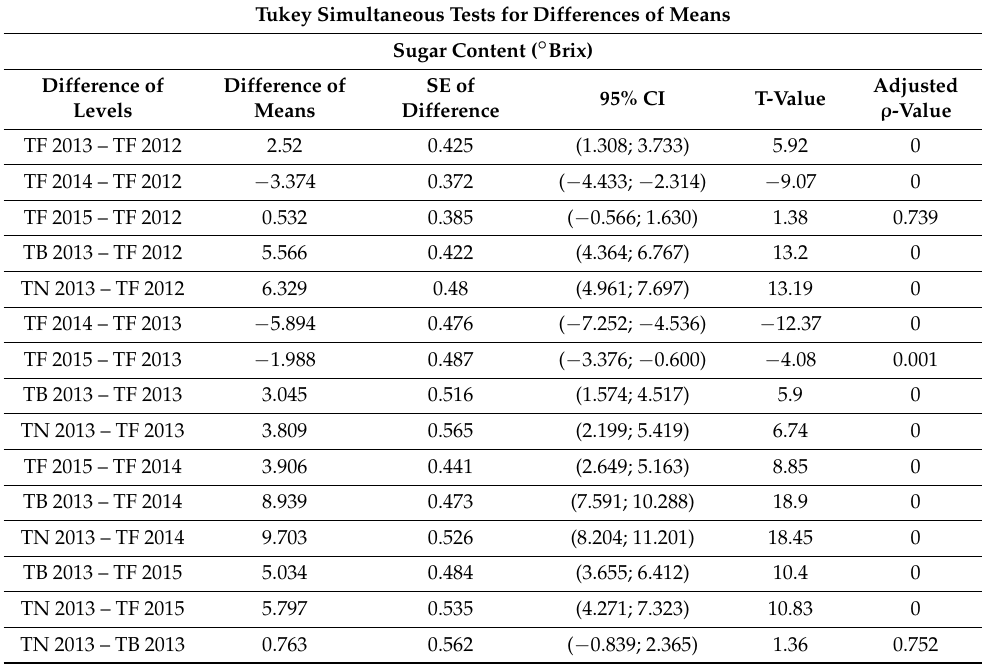
Table A6. One-way ANOVA for the sugar content of the laboratory